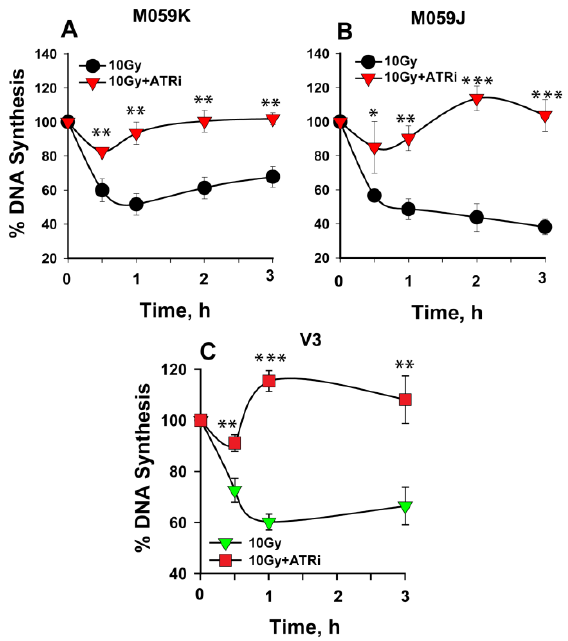
Figure 5. ATR is the key activator of the persistent intra-S-phase checkpoint in DNA-PKcs mutants. ( A ) Percentage of DNA synthesis over that of unirradiated controls measured after exposure to 10 Gy of IR in the presence or absence of ATRi in M059K cells. ( B ) As in ( A ) for M059J cells. ( C ) As in ( A ) for V3 cells. Error bars represent the standard deviation from 3 independent experiments. The significance of differences between individual measurements is indicated by * symbol: * p < 0.05, ** p < 0.01, *** p < 0.001.